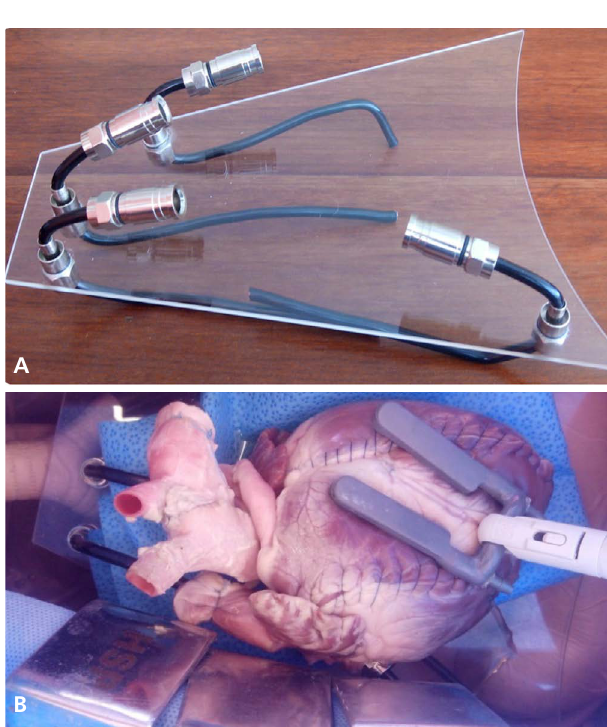
Fig. 7 - Simulation model with dummy and bovine heart. a- support model with flexible rods; b- bovine heart set on the stand.